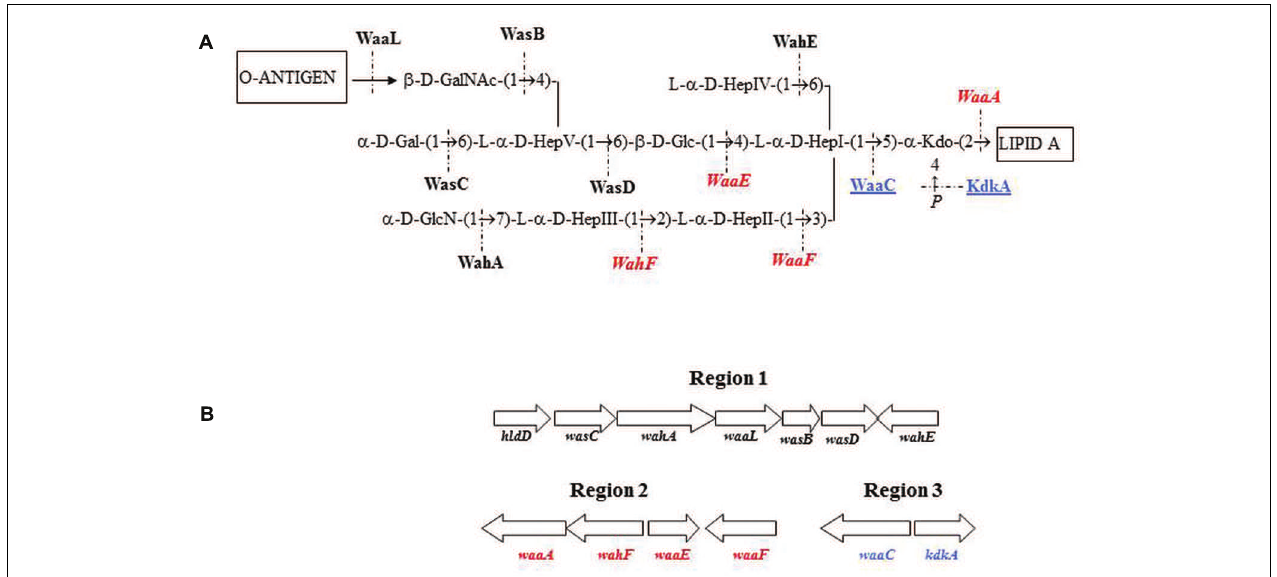
FIGURE 1 | Aeromonas salmonicida subsp. salmonicida strain A450 chemical structure (A). Proteins encoded by genes from different chromosomal regions are shown in roman type and black (region 1), in italics and red (region 2), or underlined and blue (region 3). (B) Genomic regions with the genes involved in the A. salmonicida subsp. salmonicida strain A450 waa (LPS-core biosynthesis).